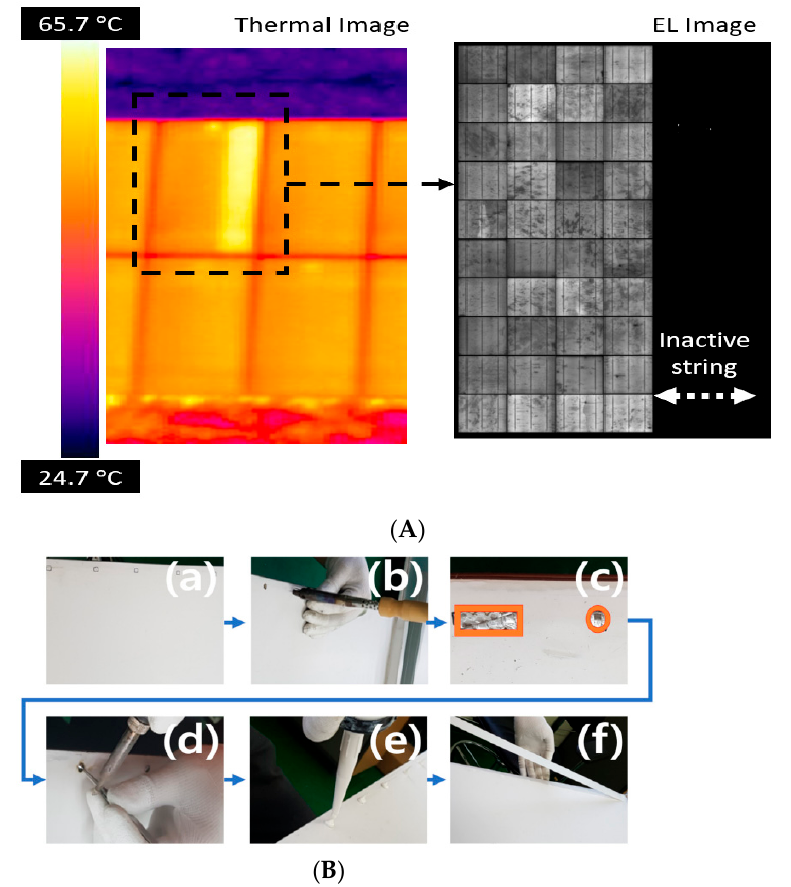
Figure 16. Thermal vs EL images of PV module affected by inactive bypass diode. PV module test: ( A ) Thermal vs EL images of PV module affected by inactive bypass diode, ( B ) Procedure for soldering and bypass diode fixing proposed by [74], the process as shown in the figure is as follows, (a) to accurately mark the punch location on the RSB hotspot part, shine a light source from the bottom of the part, (b) remove the back sheet and EVA of the part using a specially manufactured iron, (c) use tweezers to remove the carbonized EVA around the bus bar and the interconnector ribbon, and ensure that it is sufficiently dry at room temperature, (d) apply flux and re-solder the area using additional solder, and remove the solder smoke. Instead of using the lamination process, fill the re-soldering part and the part from which the EVA was removed with a silicon resin to insulate the soldering part, (e) allow the resin to dry at room temperature in a well ‐ ventilated place to remove the organic solvent, (f) apply a sealant for the PV module to the junction box of the PV module and the insulation inside the box, and finish with tape made of the same material as the back sheet.